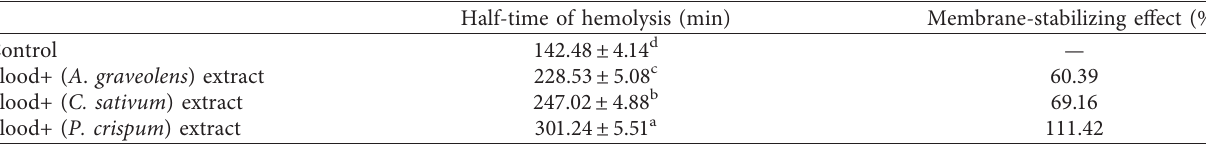
Table 4: Antihemolytic activity and the membrane-stabilizing effect induced by plant extracts.